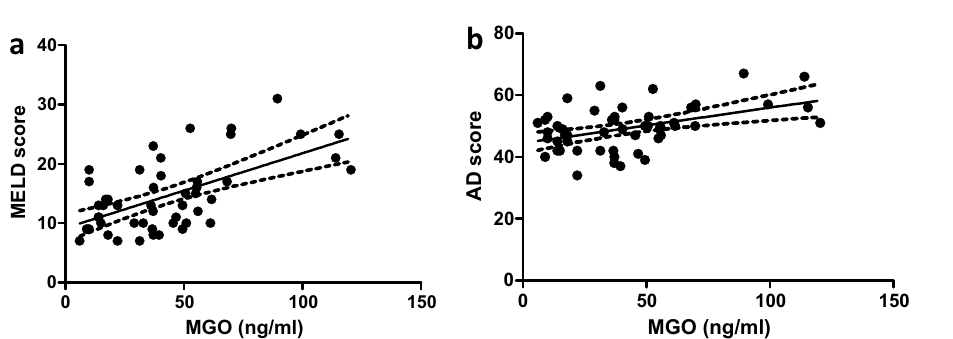
Figure 3. Circulating methylglyoxal serum levels correlate with the MELD score (effect size r = 0.529) ( a ) and AD score (effect size r = 0.373) ( b